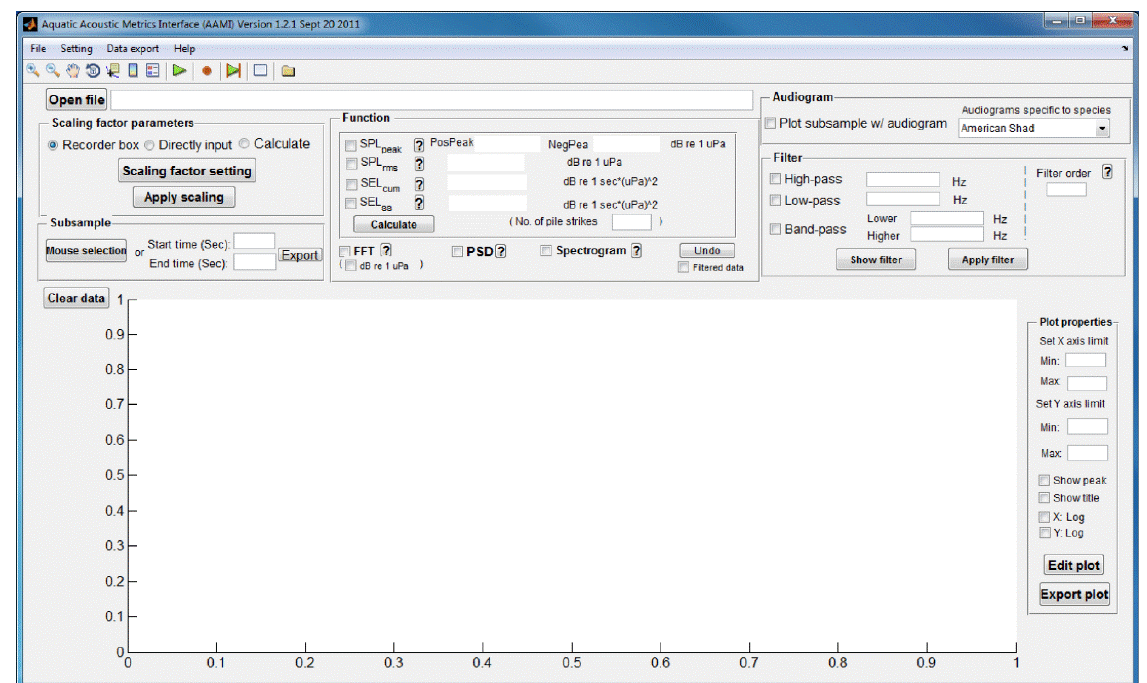
Figure 1. Main window of